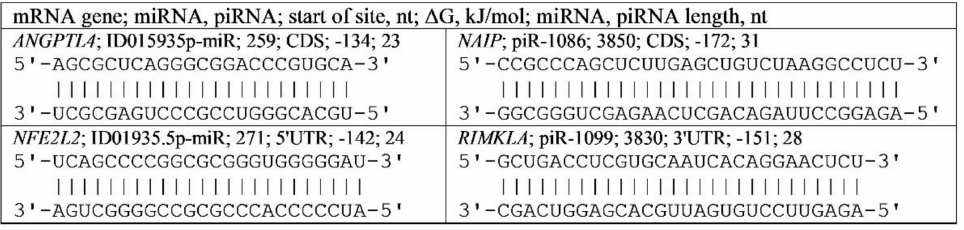
Figure 1. The characteristics of miRNA, piRNA, and mRNA ( ANGPTL4 , NFE2L2 , NAIP , and RIMKLA ) interactions with ∆ G/ ∆ Gm equal